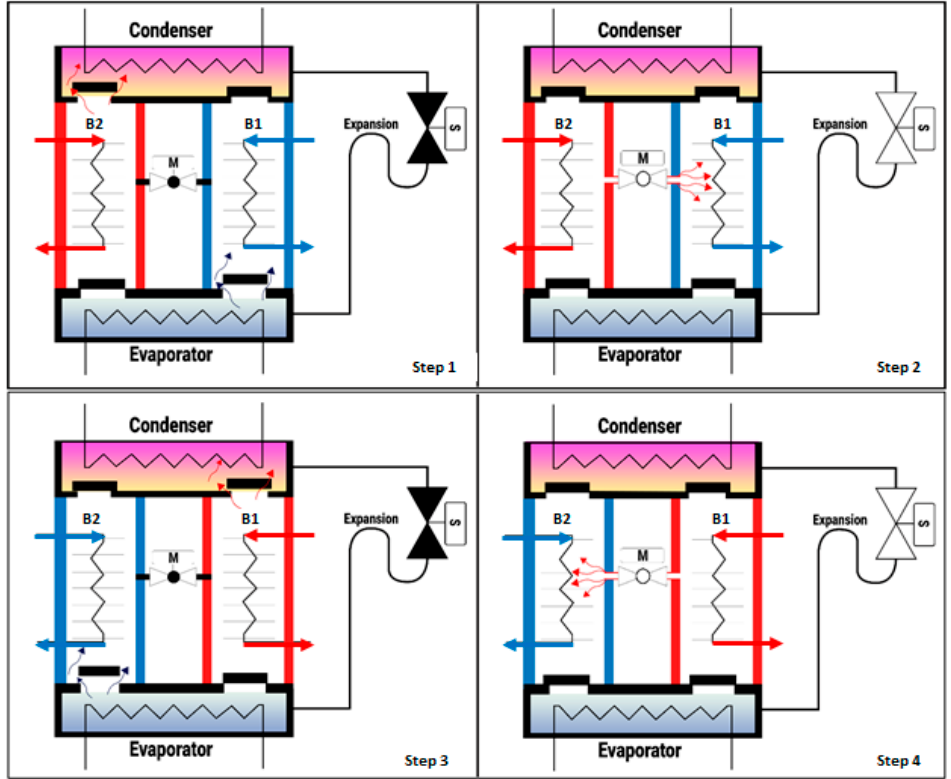
Figure 2. Variable mode adsorption chiller component.